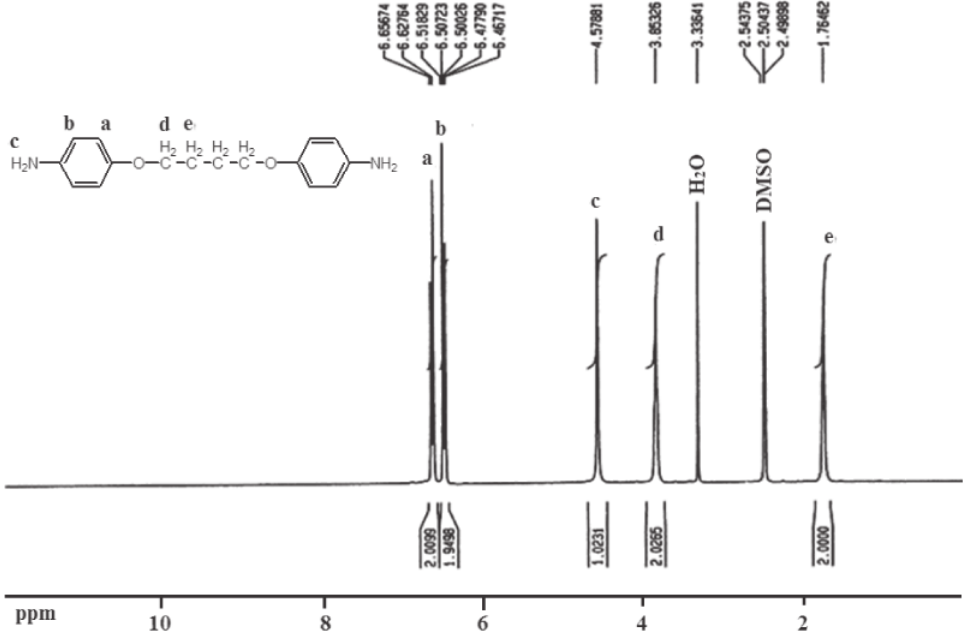
Fig. 1: 1 H-NMR spectrum of diamine